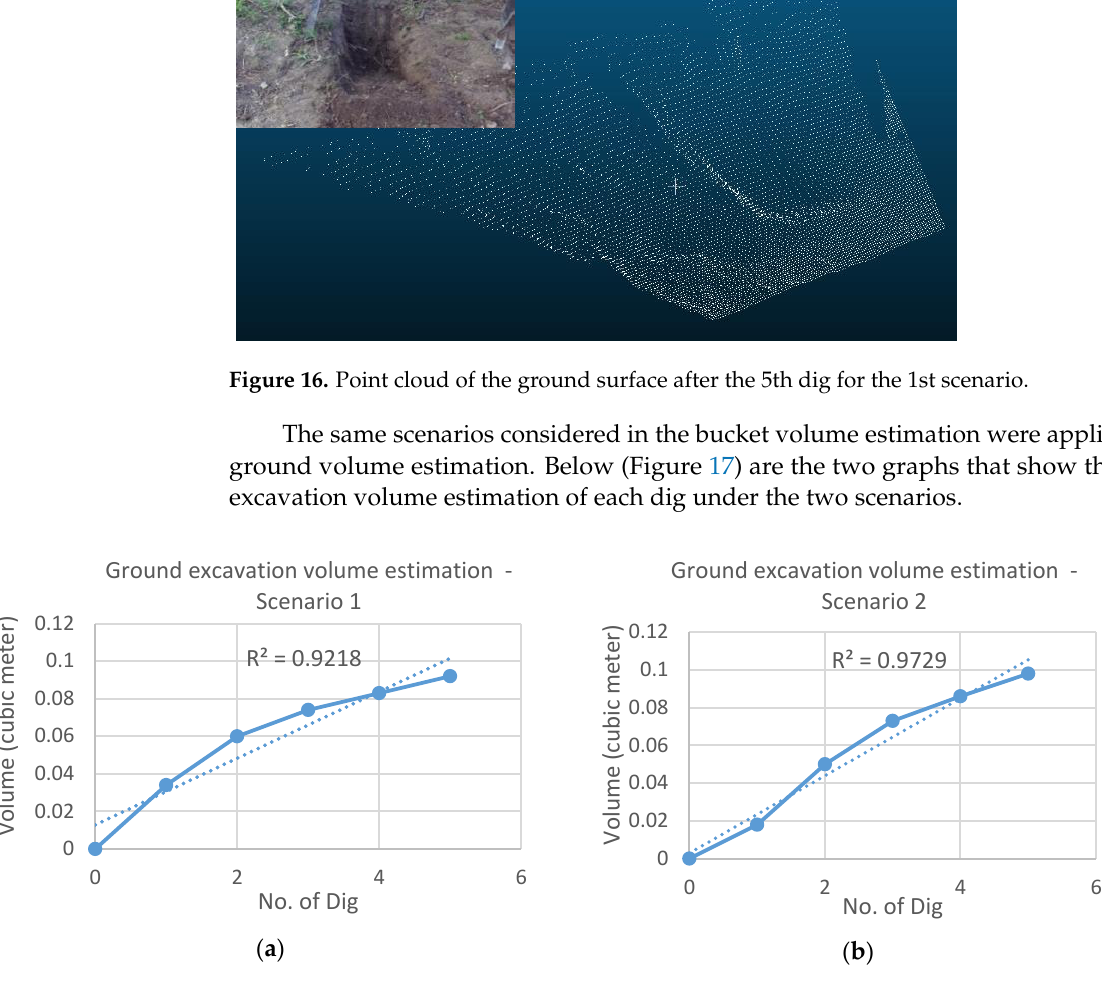
Figure 17. Result of ground volume estimation under Scenario 1 ( a ) and Scenario 2 ( b ).